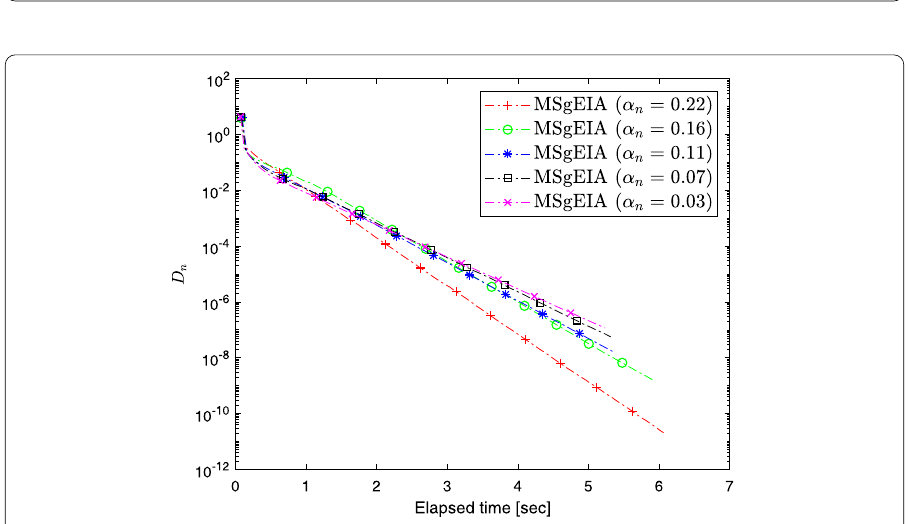
Figure 2 Experiment 5.1: Algorithm 2 behavior in terms of elapsed time relative to different values of α n